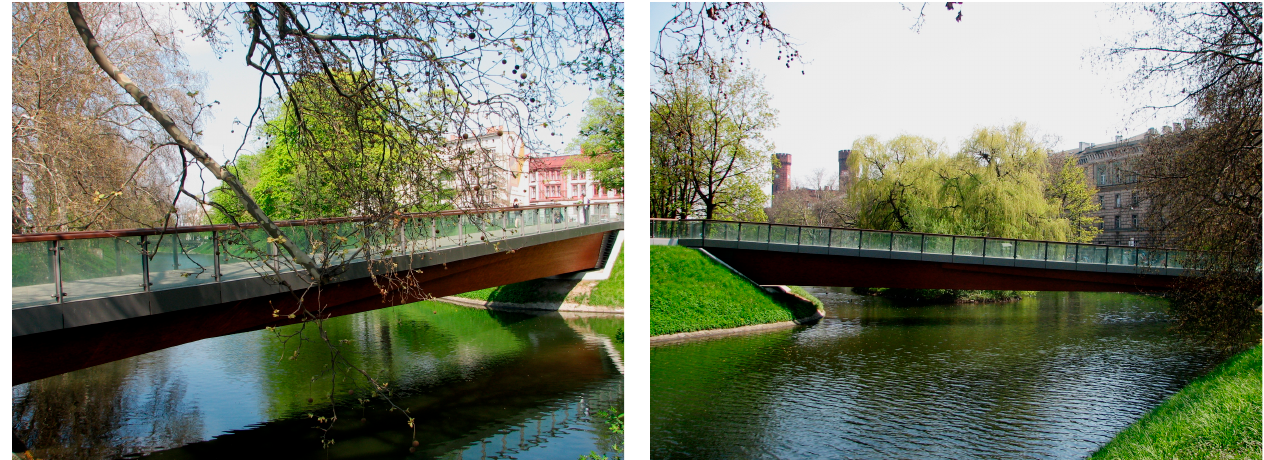
Figure 6. The beam footbridge in Wroc ł aw made of glued ‐ laminated wood. Design conditions forced the footbridge to be built to about 40 m in length. Its width has been specified to be 3.50 m. A difference in ground level between both of the moat’s banks caused the longitudinal slope of the footbridge to be about 6%. The footbridge was designed for pedestrians, as well as cyclists.